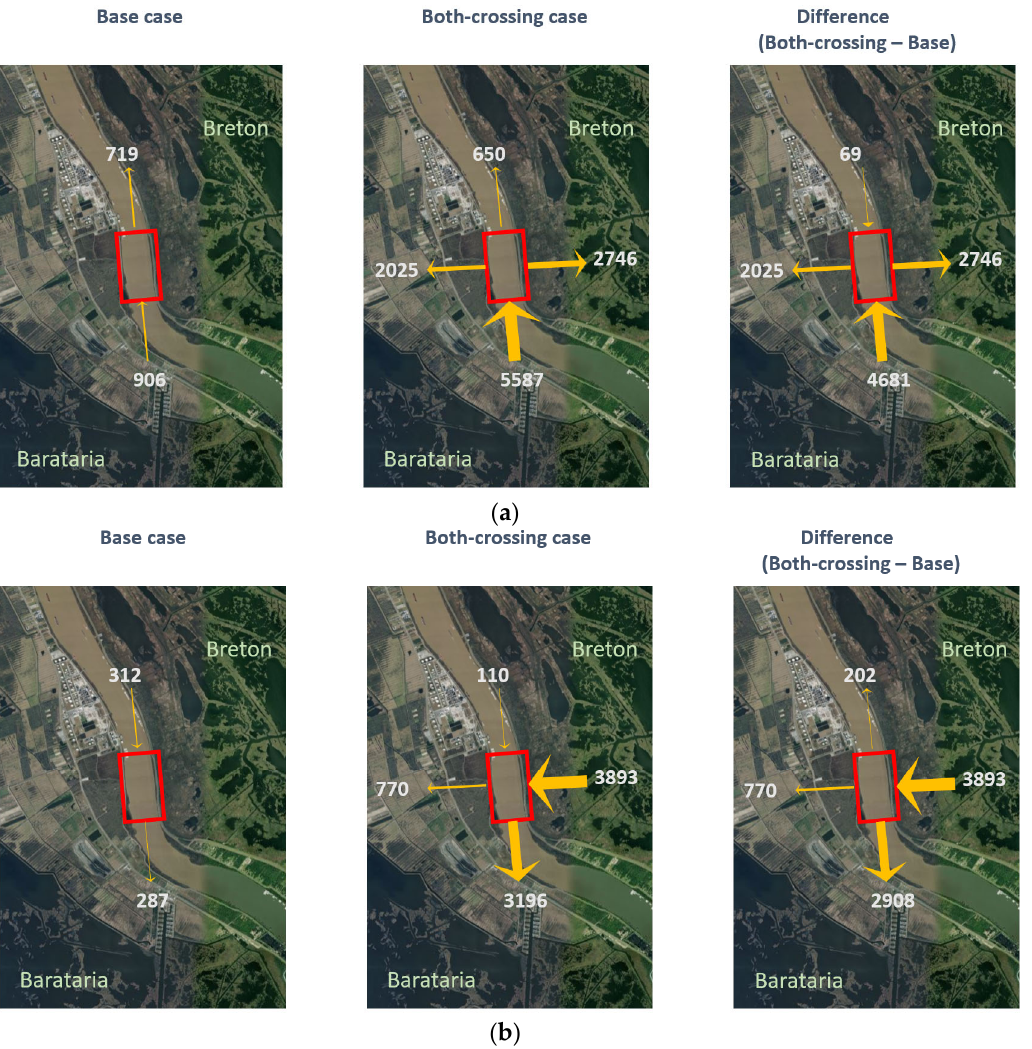
Figure 8. Flux (m 3 /s) analysis at the upper ‐ crossing location for 03:15 UTC 29 August 2012 (top) and 10:45 UTC 29 August 2012 (bottom) during Isaac (2012). The thickness of flux arrow is proportional to the amount. ( a ) 03:15 UTC 29 August 2012. ( b ) 10:45 UTC 29 August 2012.